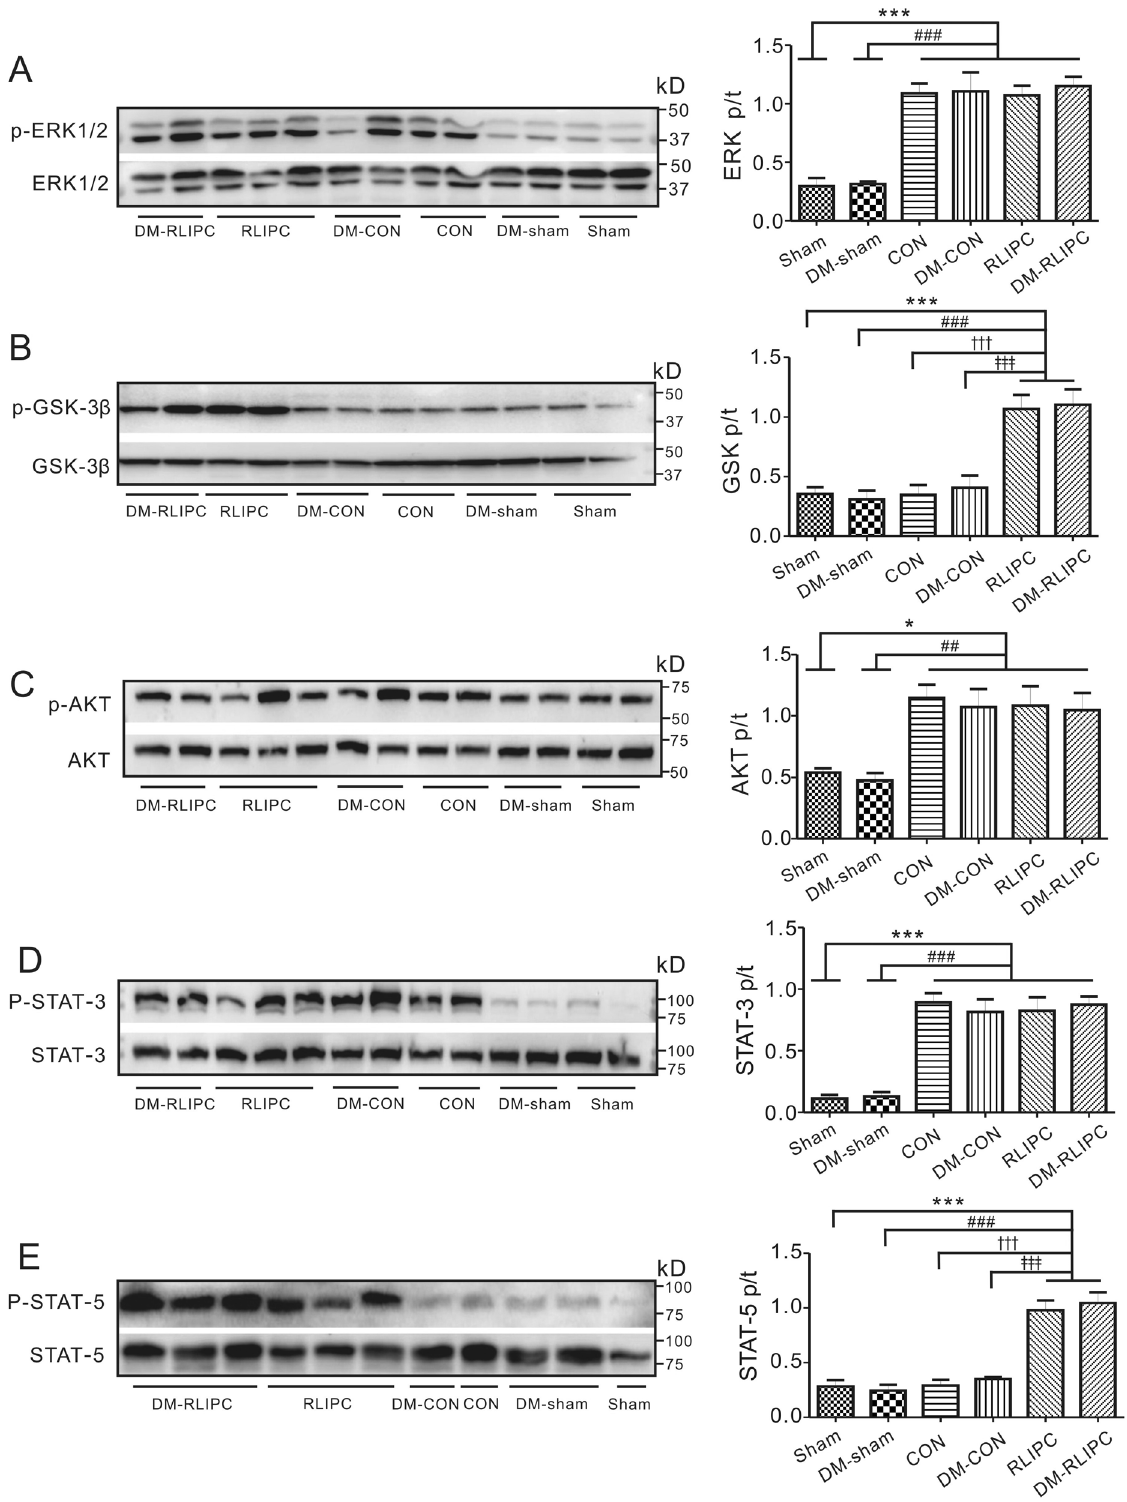
Figure 6. RLIPC stimulated GSK-3β and p-STAT-5 phosphorylation in both non-diabetic and diabetic rats. Representative Western blots (left) and quantification (right) of p-ERK1/2 ( A ), p-GSK-3β ( B ), p-AKT ( C ), p-STAT-3 ( D ) and p-STAT-5 ( E ) protein band densities (normalized to total protein, respectively) in sham, CON and RLIPC group in both non-diabetic and diabetic rats. Sham, sham surgery; CON, LAD ligation; RLIPC, remote liver ischemic preconditioning; D: diabetic rats. (n = 5–6, each group), data were presented as mean ± SEM. * p < 0.05 and *** p < 0.001 compared with Sham. # p < 0.05 and ### p < 0.001 compared